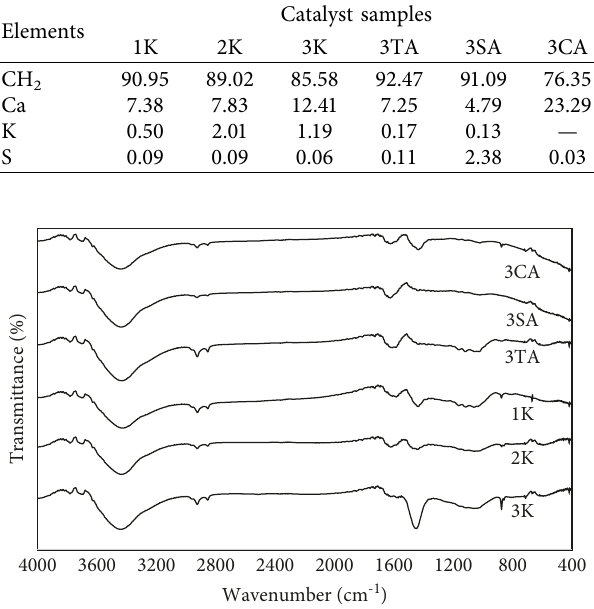
Figure 5: FTIR spectra of alkaline and acidic heterogeneous catalysts used in the transesterification of safflower oil with methanol to obtain